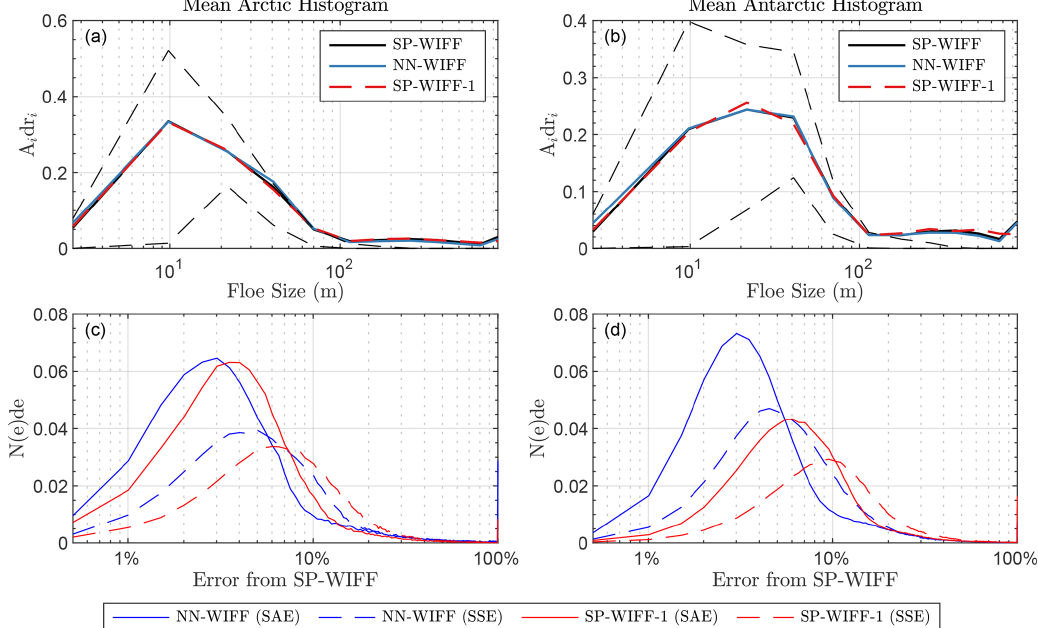
Figure 4. WIFF error characteristics in a climate model. (a) Mean Arctic histogram output A i d r i in a free-running climate simulation using (black) SP-WIFF, (blue) NN-WIFF, and (red dashed) SP-WIFF 1 . Points are included in the histogram if all three cause wave fracture. The interquartile range of SP-WIFF outputs is given as dashed black lines. (b) Same as (a) for the Antarctic. (c) Histogram of errors between SP-WIFF and (blue) NN-WIFF or (red) SP-WIFF-1 in the Arctic. Solid lines are the sum of absolute error (SAE). Dashed lines are the standardized size error (SSE). (d) Same as (c) for the